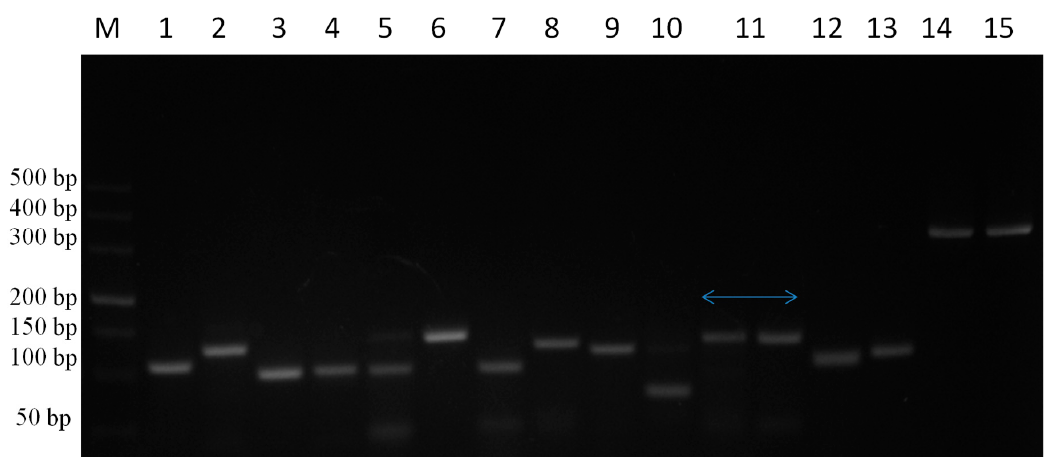
Figure 7. PCR amplification of cytokine genes from TaBCs DNA and cDNA using specific primer pairs. Here, M represents the DNA marker (DL500), while lines 1–15 indicate IL1A, IL1B, IL2, IL4, IL6, IL8, IL10, IL12A, IL12B, IL16, TNFA, IFNB, IFNA, LTA, and TGFB1, respectively, amplified from DNA and cDNA harvested from of transformed B cells. Table 2. Linearity measurements from regression analysis, mean fold changes, and standard deviation (SD) values of cytokines produced in T. annulata -transformed (TaBCs), BW720c-treated transformed cells, and LPS-stimulated normal B cells (nBCs) and TaBCs.